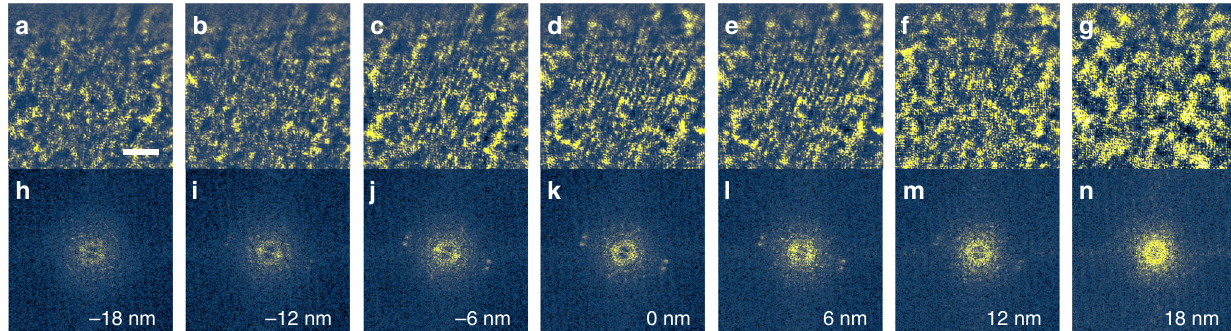
Fig. 4 Evaluation of depth resolution. a – g Reconstructed phase using seven slices from a 21-slice reconstruction with a step of 6 nm along the optical axis and h – n , corresponding power spectra. Lattice fringes, (0002) with a spacing of 0.34 nm and their corresponding re fl ections fade outside a sample height range from − 12 to 12 nm. This con fi rms a depth resolution of about 24 – 30 nm for the spatial frequency corresponding to the 0.34 nm lattice spacing. The 2 nm scale bar is the same for a – g . The values in h – n are de fi ned as the distance from the focus plane of the lower CNT, which is at depth of